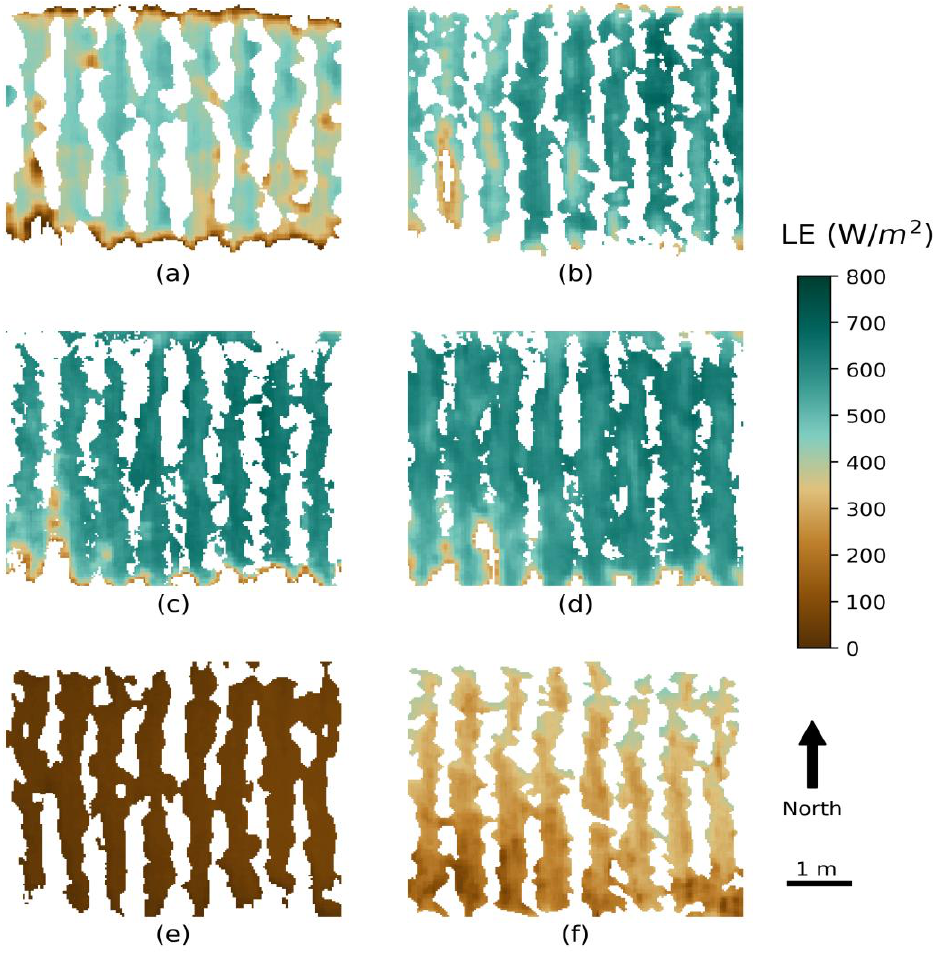
Figure 8. Latent heat flux estimates for the target plot in F54 north of six different dates. ( a ) 2 July